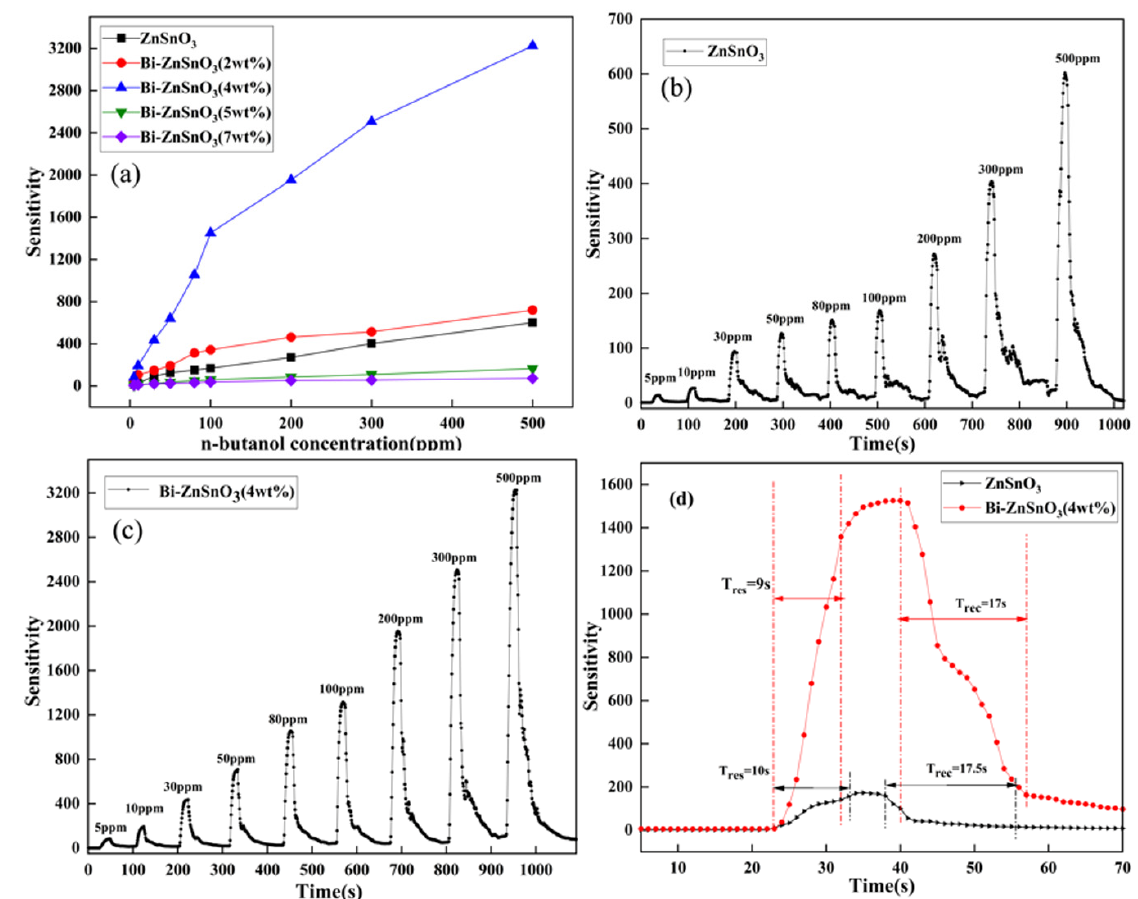
Figure 8. The relationship between the sensitivity of different materials and the concentration of n-butanol gas ( a ), the concentration–response curve of pure ZnSnO 3 material to n-butanol gas at 325 °C ( b ), the concentration–response curve of Bi-ZnSnO 3 to n-butanol gas at 300 °C ( c ), and the response recovery curve of pure ZnSnO 3 and Bi-ZnSnO 3 (4 wt%) materials to 100 ppm n-butanol gas ( d ).